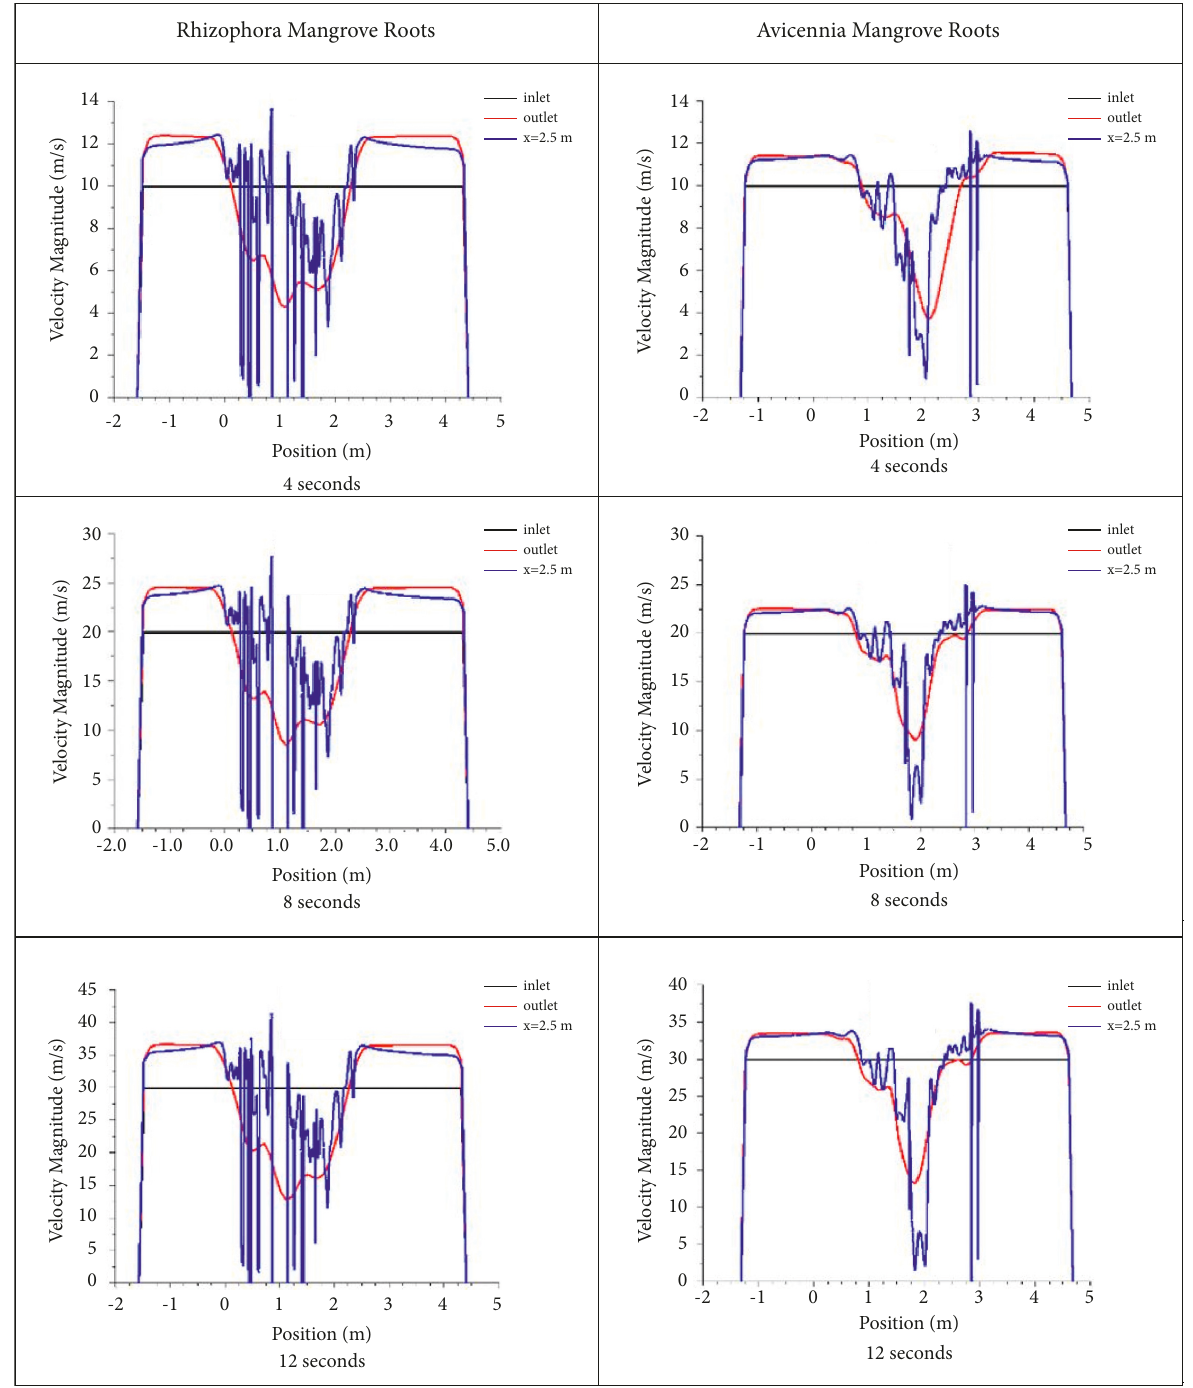
Figure 7: Velocity dissipation of unsteady air flow by Rhizophora and Avicennia mangrove roots at inlet, outlet, and x � (green contour) and 12.5 Pa, 18.7 Pa, and 150.4 Pa (yellow and − 300.6 Pa (green contour) and 22.3 Pa, 81.2 Pa, and contour). The root near the left side of the primary root (the 175.6 Pa (yellow color). second enlarged image) indicates the pressure near the root is 12.5 Pa, 18.7 Pa, and 150.4 Pa (yellow contour) and 25.5 Pa, 129.2 Pa, and 275.4 Pa (dark yellow contour). The indicated in Figure 8 (right side). The root away from the left root near the right side of the primary root (the third en- side of the primary root (the first enlarged image) shows that larged image) represents the pressure near the roots is the pressure near the roots is − 0.5 Pa, − 35.7 Pa, and − 50.5 Pa